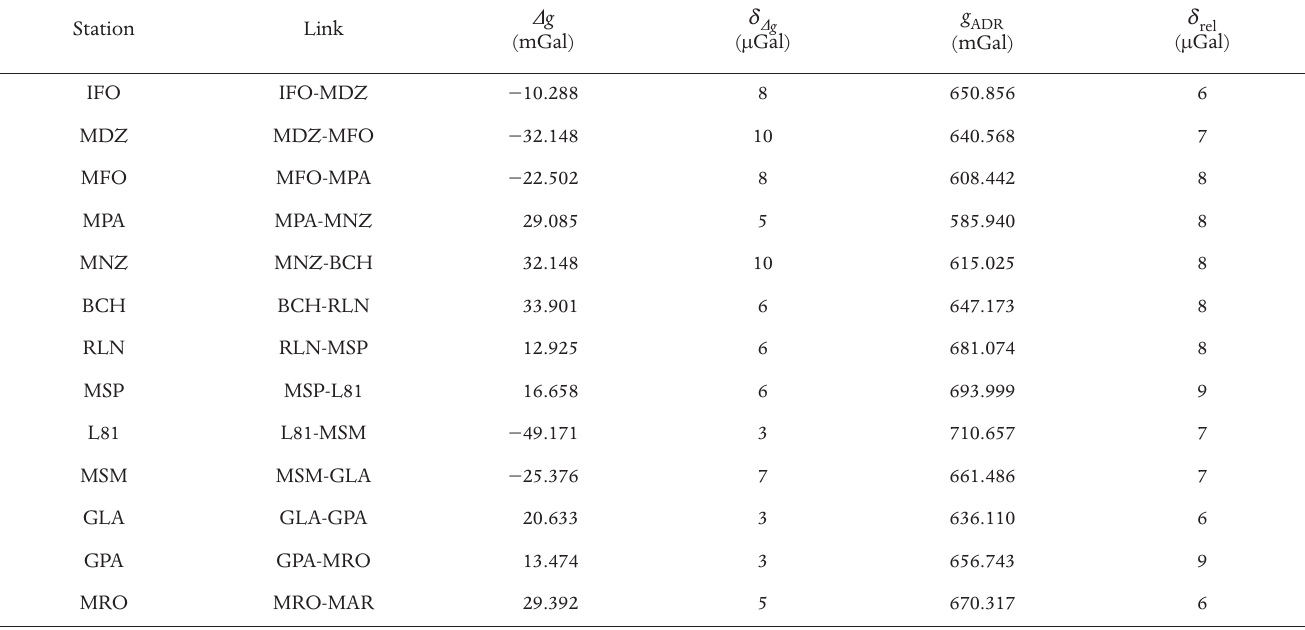
Table 2. Results of the traditional gravity measurements acquired in 2005 for the 13 selected relative gravity stations of the Mt. Etna gravity network. The columns indicate, respectively, the station acronyms, the links between two adjacent relative stations, the gravity differences ( D g ) between each pair of adjacent relative stations; the uncertainties ( d ) associated to each (cid:0) D g ; the gravity values ( g ) at each station obtained with the least-squares method, ADR D g as described in the text and referred to ADR station, and the associated errors ( d rel